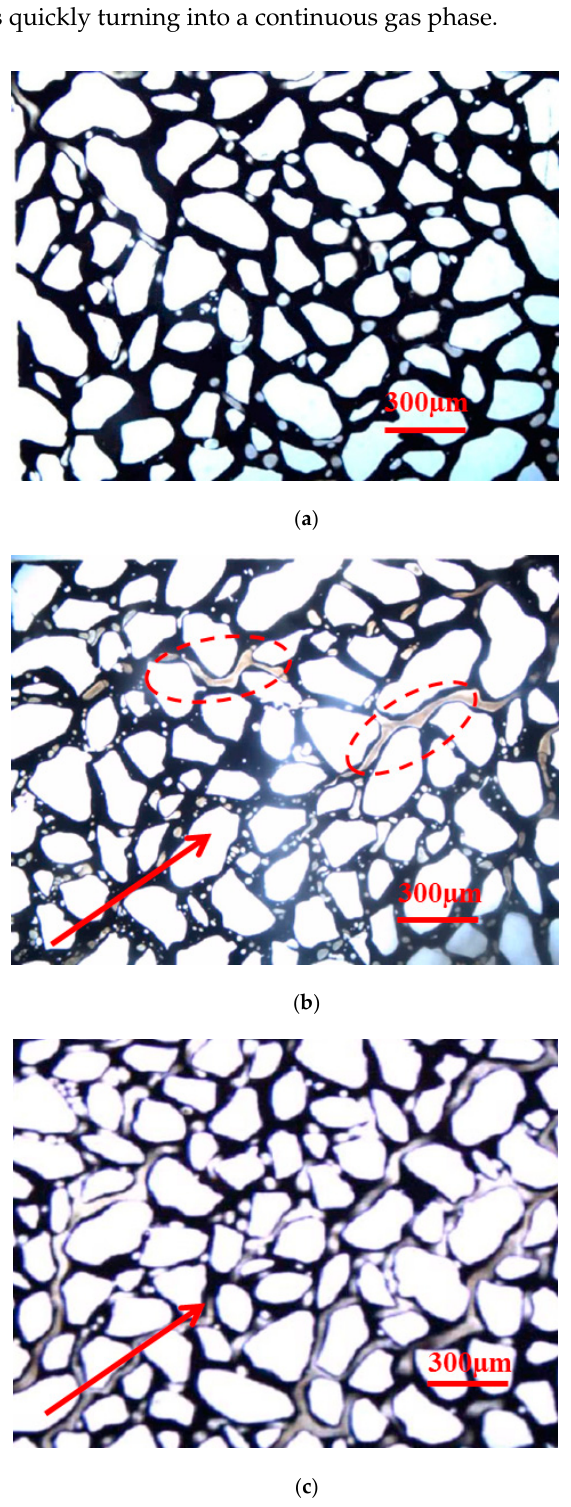
Figure 9. Flow characteristic of each type of depletion development: ( a ) foamy oil depletion development; ( b ) weak foamy oil depletion development; ( c ) conventional solution gas drive.